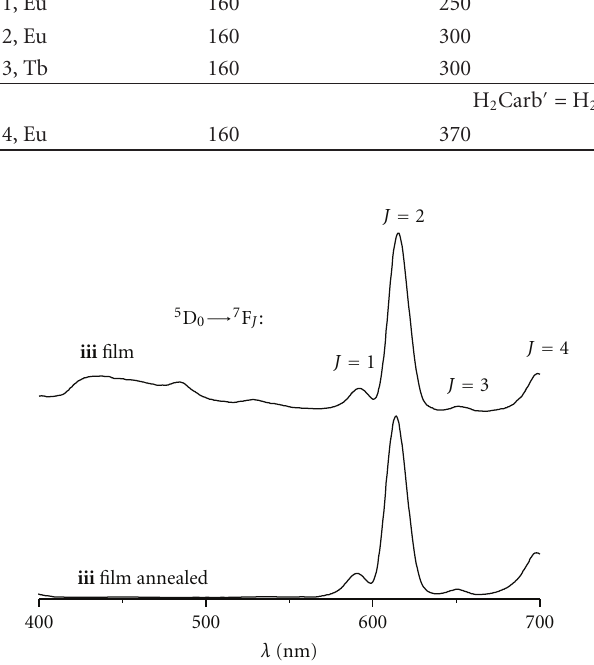
Figure 12: Normalized emission spectra of iii film and iii annealed film ( λ ex = 260